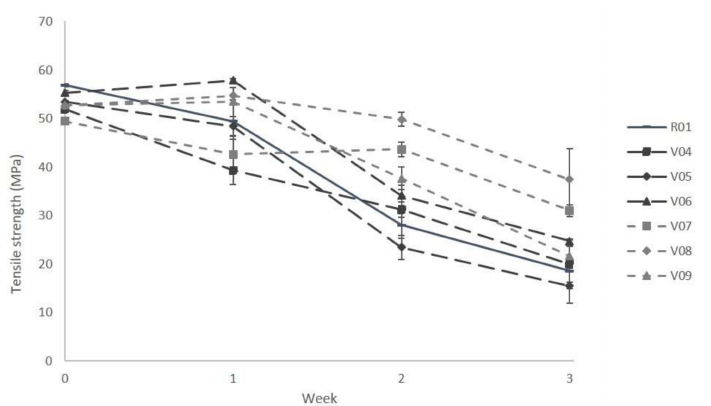
Figure 5. Tensile strength of PLA/PBS-based blend systems (7:3) loaded with 5 and 15 phr of coarse talc, fine talc and chalk, after 0 to 3 weeks located under industrial composting conditions. Compositions: R01: unfilled reference; V04/V07: plus 5/15 phr coarse talc; V05/V08: plus 5/15 phr fine talc; V06/V09: plus 5/15 phr chalk.